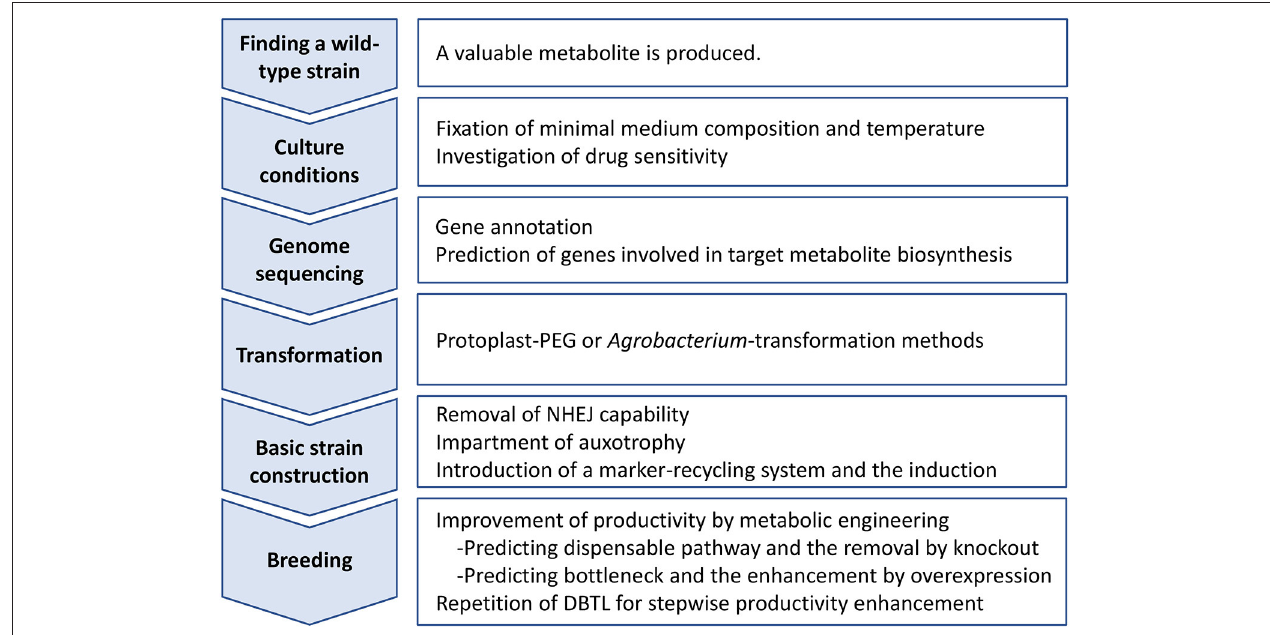
FIGURE 1 | Outline of industrial strain improvement of filamentous fungi for enhancing productivity of a target metabolite. DBTL, Design-Build-Test-Learn cycle; NHEJ, non-homologous end joining; PEG, polyethylene